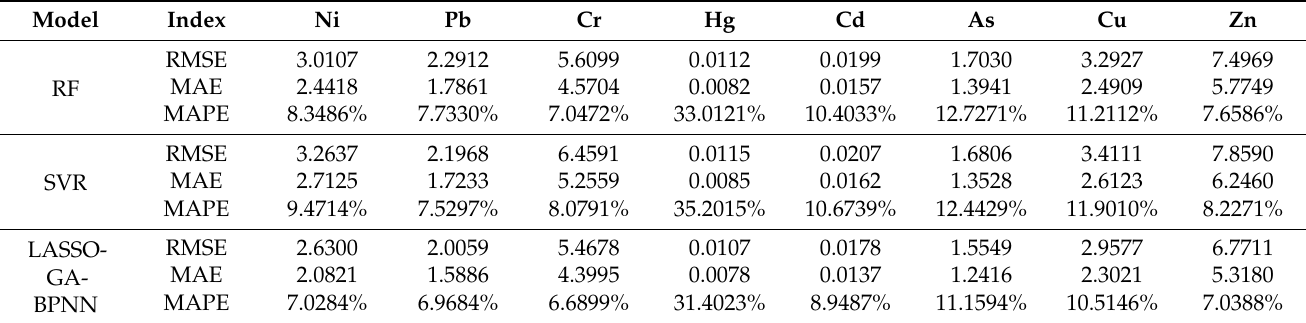
Table 4. Accuracy evaluation index.